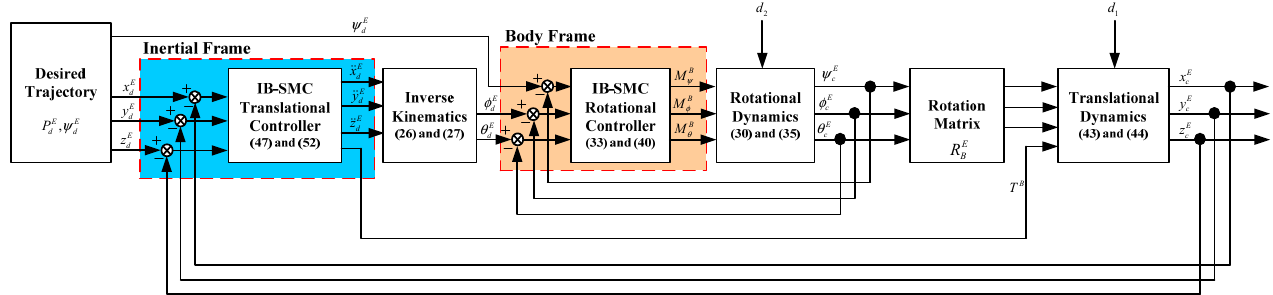
Figure 2. Block diagram of control structure of quadrotor.